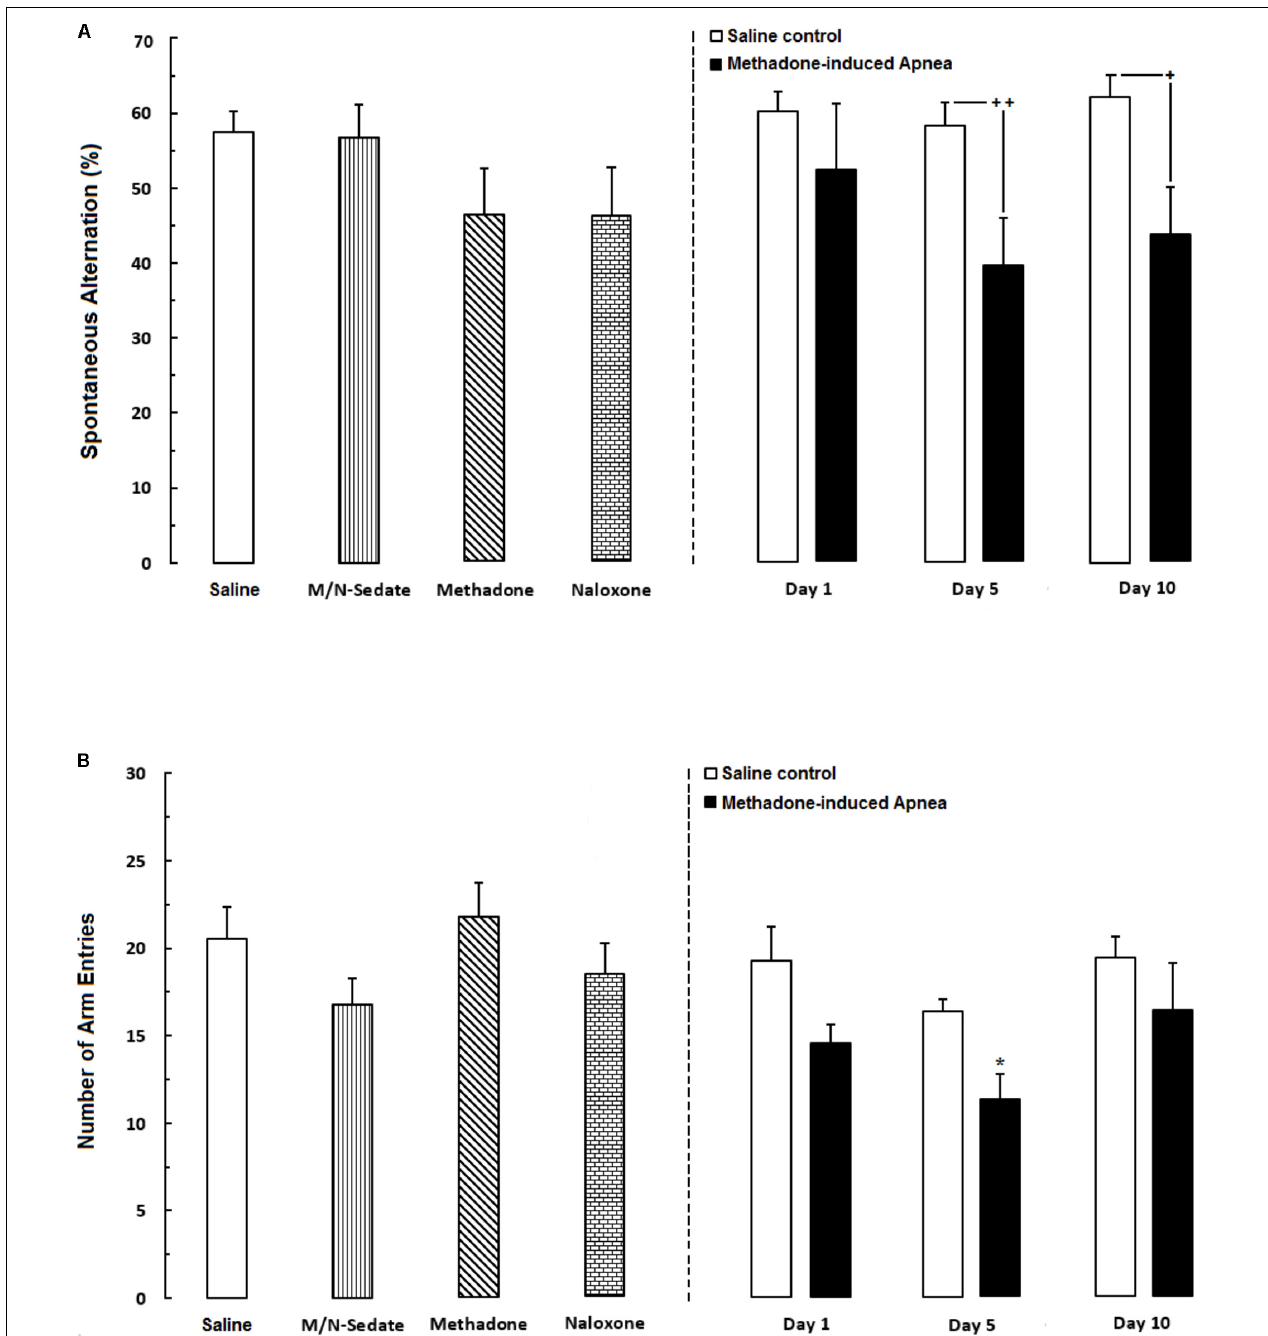
FIGURE 2 | (A) Spontaneous alternation behavior and (B) Total number of arm entries were recorded in different groups, including; M/N-treated groups (a single dose of naloxone was administered after methadone overdose in apnea stage, in animals which experienced apnea and spontaneous alternation behavior was evaluated either on day 1, 5, or 10 day post-resuscitation; M/N-Day 1 ( n = 6), M/N-Day 5 ( n = 6) and M/N-Day 10 ( n = 6) groups and their respective Saline control groups; n = 6 right panel), M/N-Sedate ( n = 8; a single dose of naloxone was administered following methadone overdose, immediately in the initial stage of sedation, so behavioral evaluation was carried out only 1 day after drug administration), Saline; n = 12, methadone; n = 8 and naloxone; n = 7 (saline, methadone or naloxone were administered alone in separated groups in which spontaneous alternation behavior and the number of arm entries were recorded only 1 day after drug administration during an 8-min trial in adolescent rats) groups. Animals received methadone (15 mg/kg; i.p.) or naloxone (2 mg/kg; i.p.) alone or both (apnea groups) in a single dose. Each bar shows the mean ± SEM for 6–12. ∗ P < 0.05 different from the Saline group. + P < 0.05 and ++ P < 0.01 different from their respective Saline control